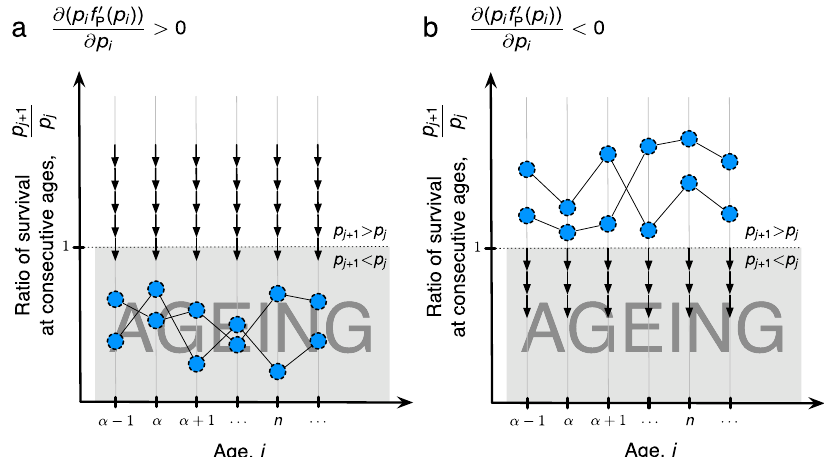
Fig. 3 Evolutionary dynamics of survival. a , b Dynamics of survival evolution depend on how genetic variation acts on survival p i from each age i to the next age i + 1. There are two main cases that are captured by the function f P (see Methods). Only survival that leads into reproductive ages is here considered with α the fi rst reproductive age. The existence, number, and stability of equilibria remain undetermined in the general case. a Dynamics, depicted here as arrows, always lead survival at one age to be larger than survival at the next age. Any equilibrium survival schedule shows a decline of survival with each successive age. b If there are equilibrium schedules where survival increases with age, these equilibria are located within a region that dynamics always